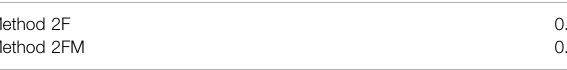
Frontiers in Built Environment |